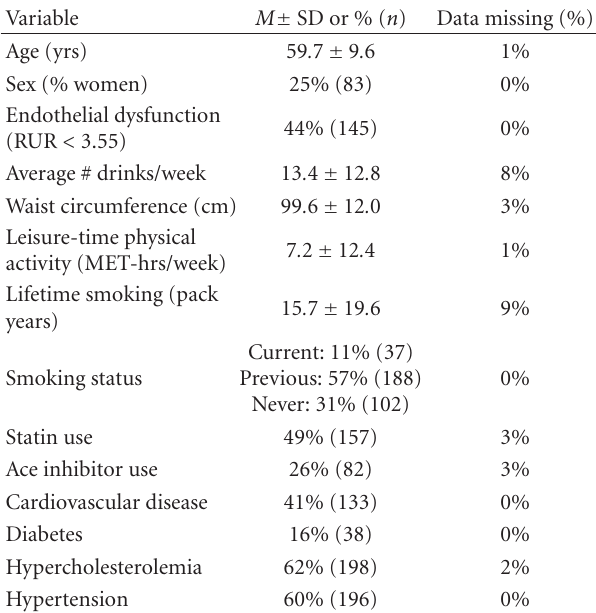
Table 2: Participant